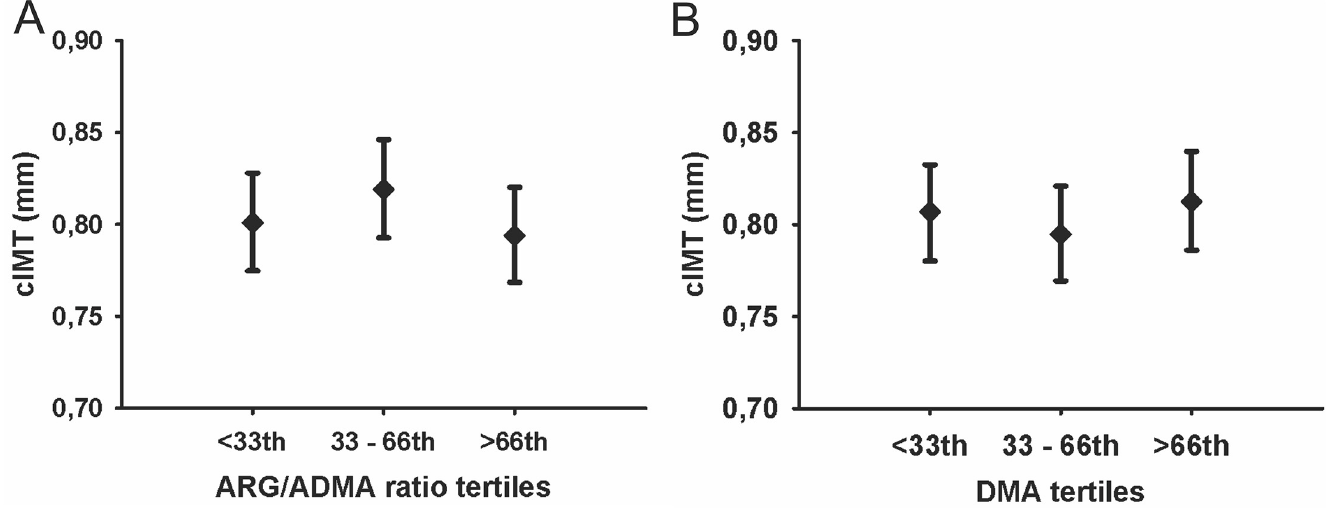
Fig 2. Estimated mean of cIMT with 95%-CI by ARG/ADMA ratio (A) and DMA (B). Multivariate analyses of variance were adjusted for age, sex, WHR, smoking, physical activity and GFR. Post-hoc comparison adjusted for multiple testing using Tukey. (cIMT indicates carotid intima-media thickness; ARG/ ADMA, arginine asymmetrical dimethylarginine ratio; DMA, dimethylarginine).